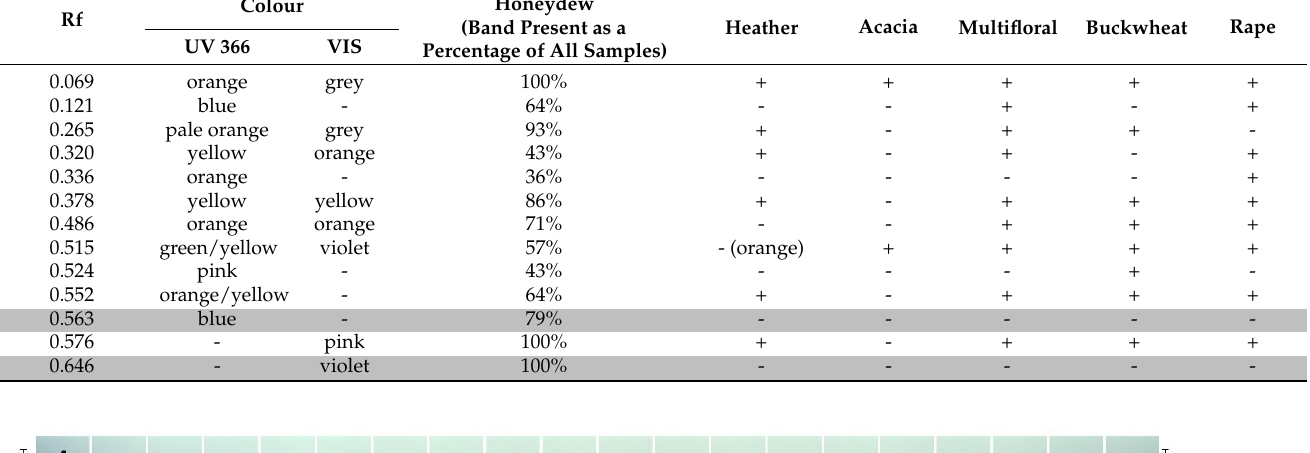
Table 4. Characteristic Rf values for detected phenolic compounds in tested honeys. Two specific bands for honeydew honey were highlighted in gray.